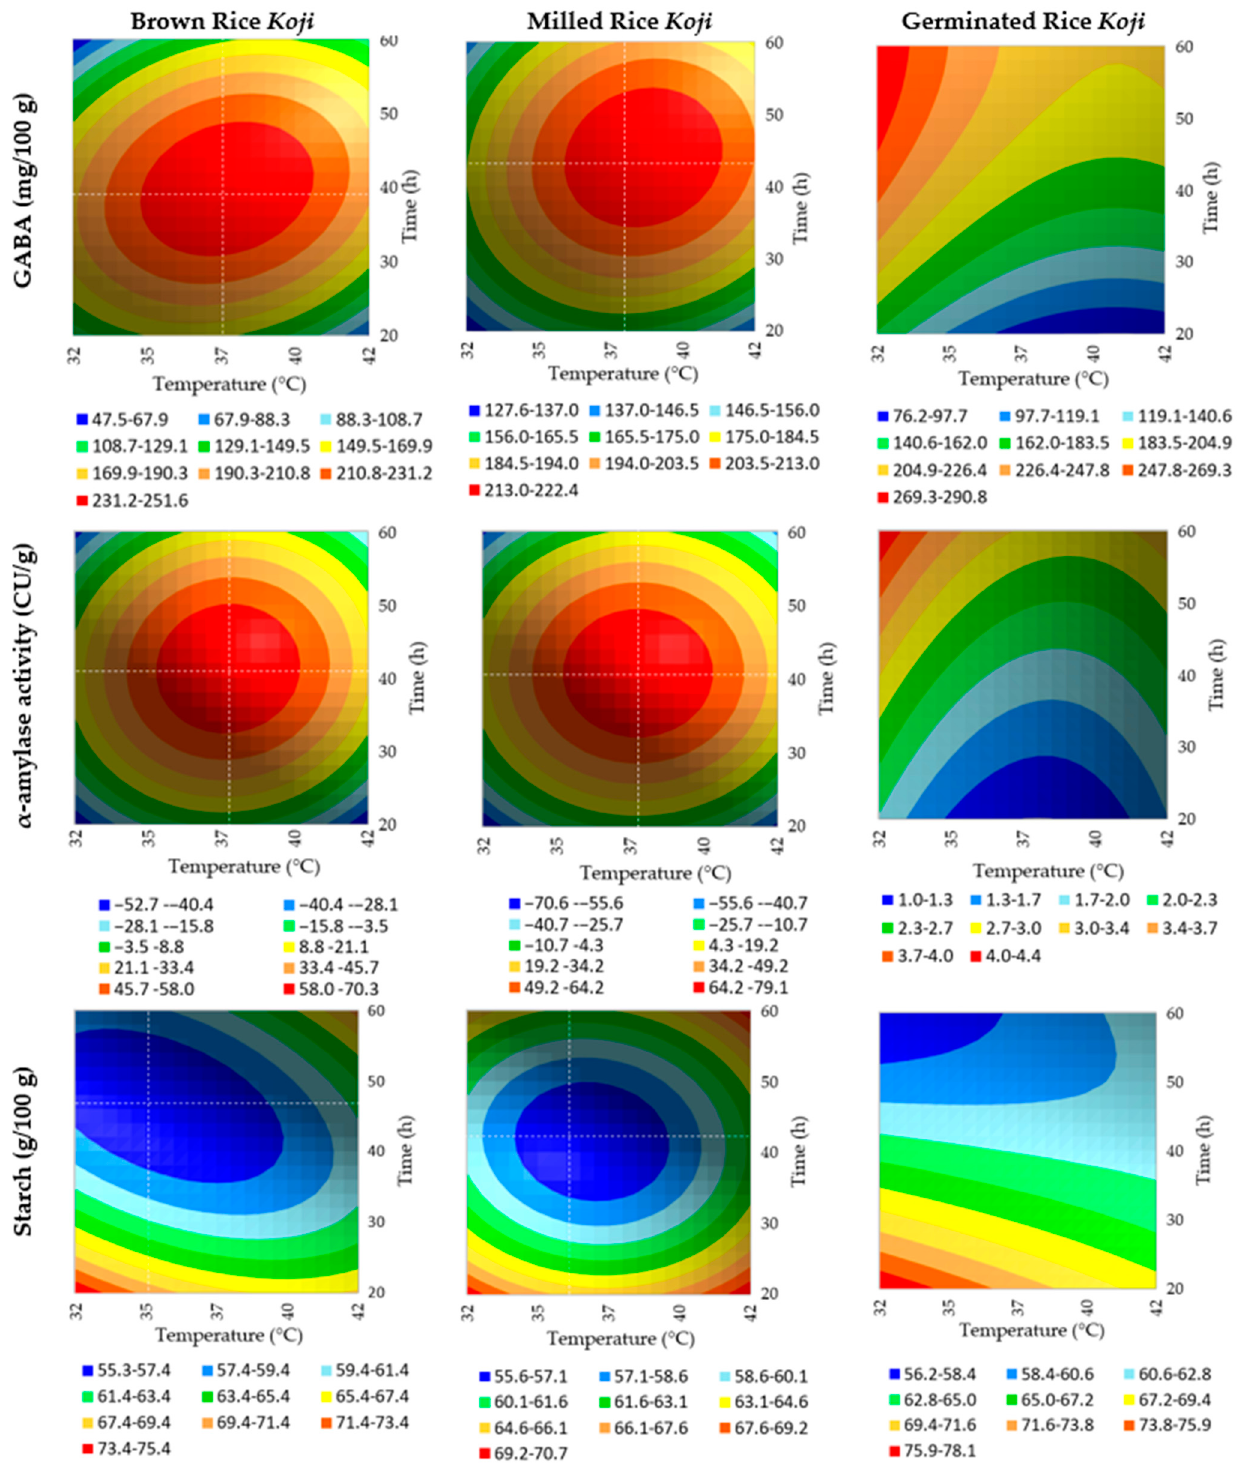
Figure 3. Contour plots of the predicted model for GABA, α -amylase activity and starch on brown, milled and germinated rice Koji . In GABA and α -amylase activity plots, white lines represent the temperature ( ◦ C) and time (h) targets to obtain the maximum response for GABA and α -amylase, and the minimum response for starch